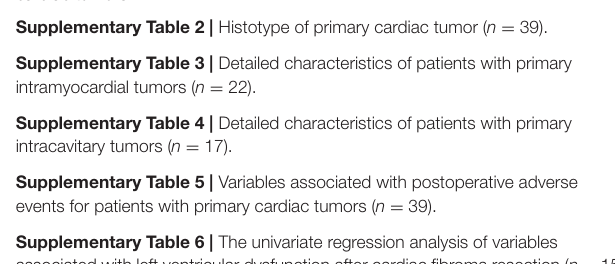
Supplementary Table 6 | The univariate regression analysis of variables associated with left ventricular dysfunction after cardiac fibroma resection ( n =